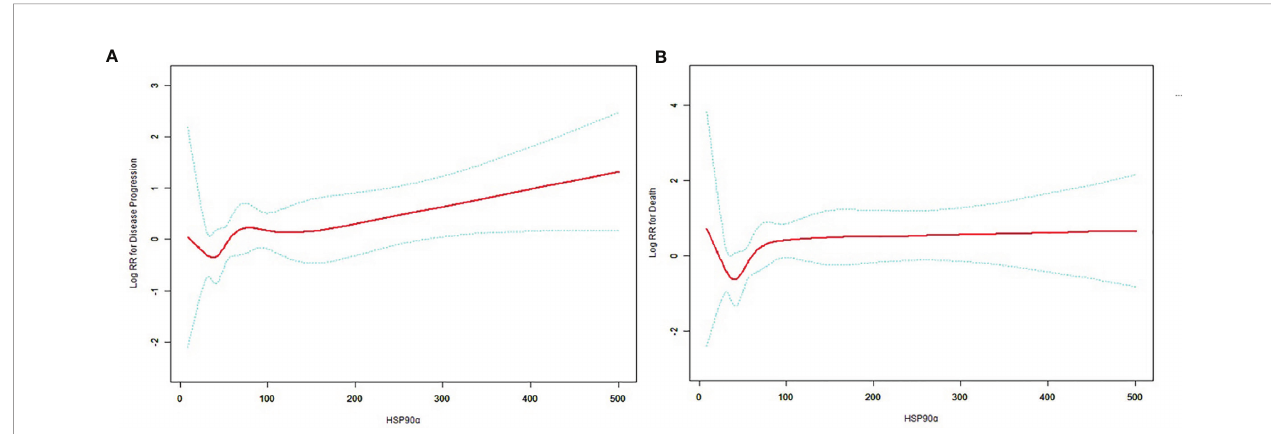
FIGURE 2 | The curve fi tting plot between plasmatic levels of HSP90 a at diagnosis and the risk of disease progression (A) and death (B) . The estimated values and corresponding 95% con fi dence intervals were represented by the solid line and dashed line. The in fl ection point of the curve was 52.7 ng/ml.